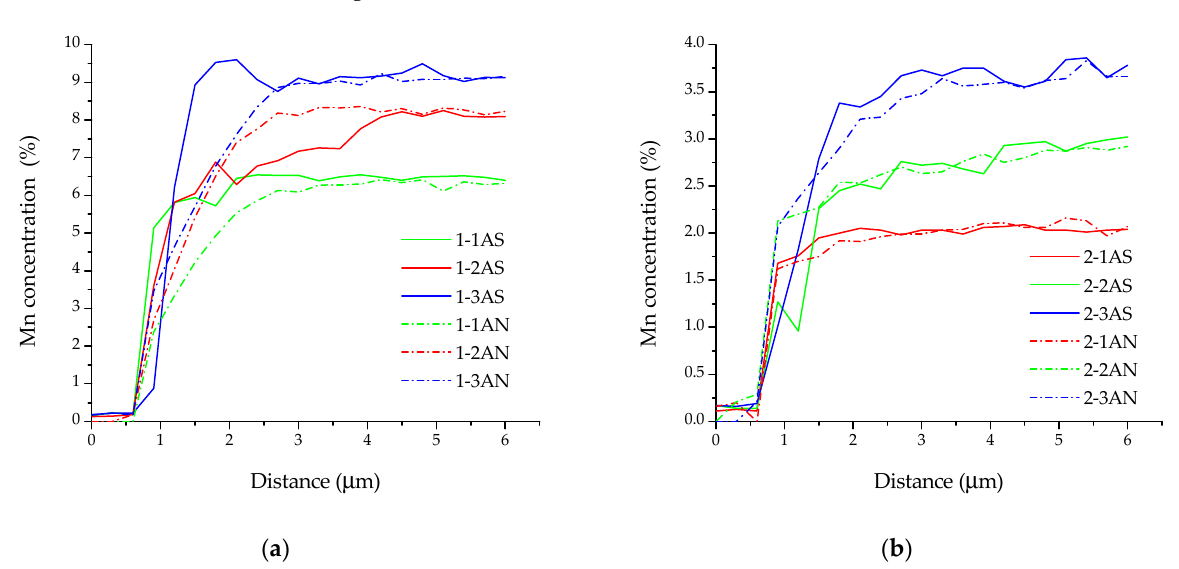
Figure 3. Concentration of manganese in the height of the samples in the state after printing ( X - Y AS) and after annealing ( X - Y AN): ( a ) fabricated from Alloy 1; ( b ) fabricated from Alloy 2.